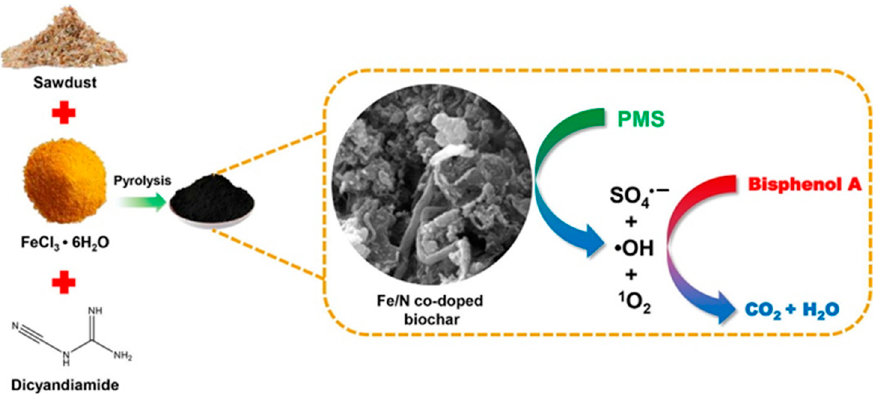
Figure 2. Schematic illustration of the preparation of Fe-NBC [78], copyright 2020, Elsevier.